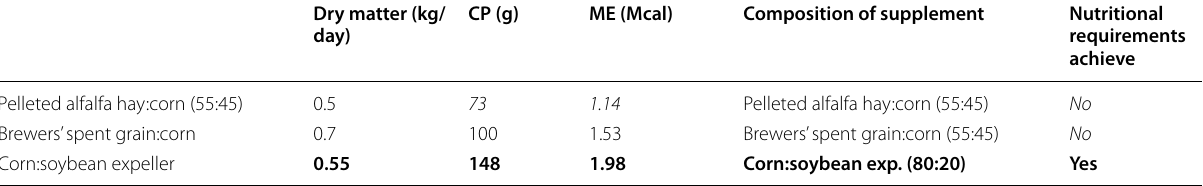
Table 6 Contribution of the different concentrates and their possibility to meet the nutritional requirements of pregnant goats Dry matter (kg/ CP (g) ME day)